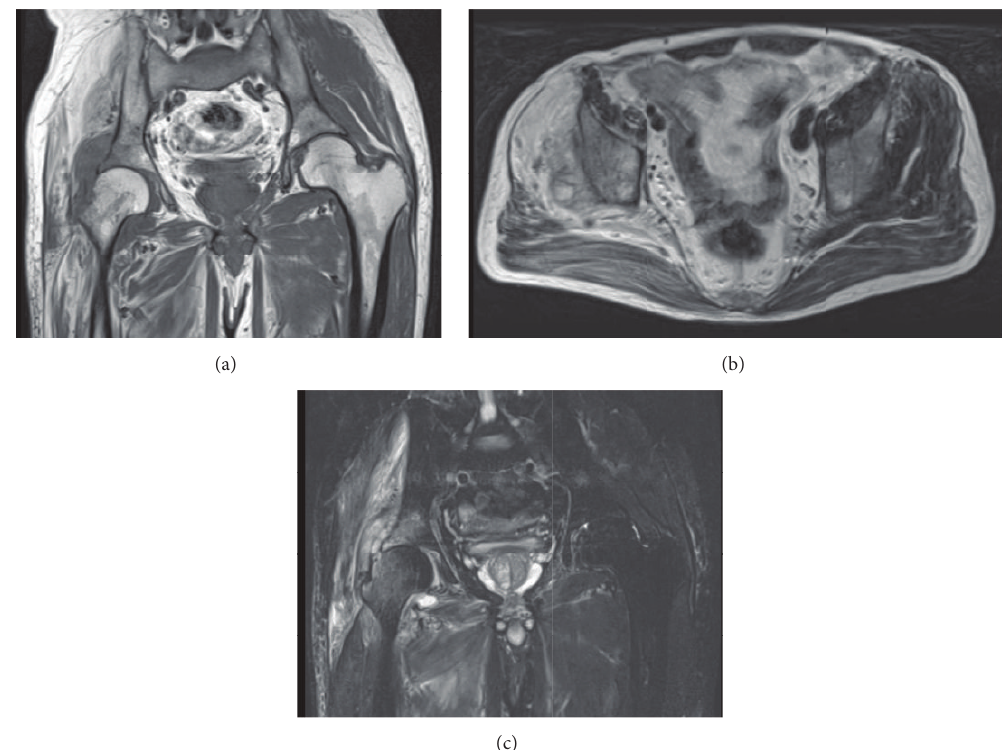
Figure 1: Initial MRI of the hip: (a and b) coronal T1-weighted and axial T2-weighted images showing inhomogeneous fatty signal changes in the gluteus medius muscle and (c) coronal STIR image showing apparent high signal lesions in both the gluteus medius and minimus muscles and slightly high signal lesions in both the femoral head and the acetabular bone with the joint effusion.